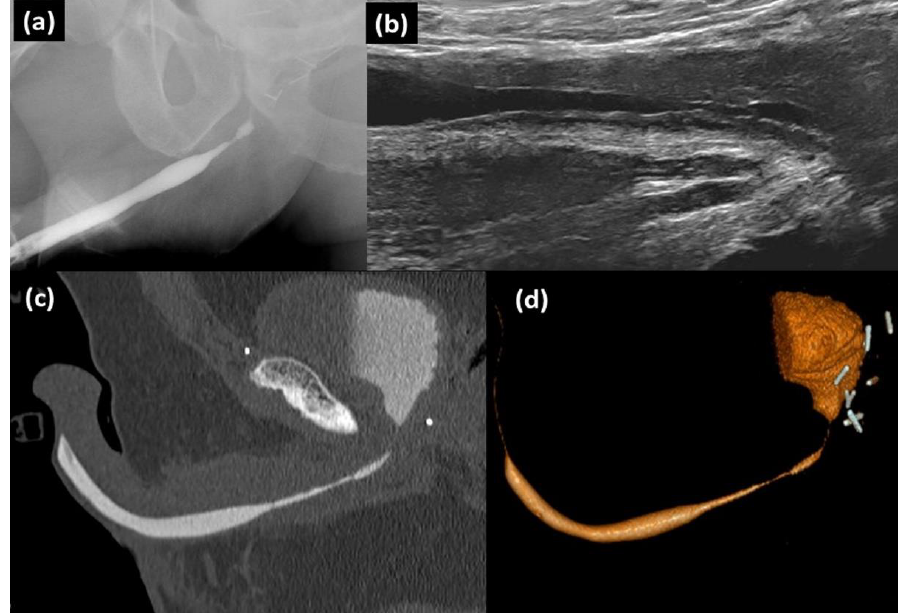
Figure 4. Patient with bulbar stenosis of a length underestimated by urethrography: ( a ) RUG showing 2.8 cm stenotic bulbar segment; ( b ) RSUG in panoramic mode (extended FOV) to visualise all of the bulbar stenosis and surrounding spongiofibrosis, measuring 4.2 cm in length; ( c ) CT-RUG showing 4.3 cm stenotic bulbar segment. ( d ): 3D CT-RUG image.